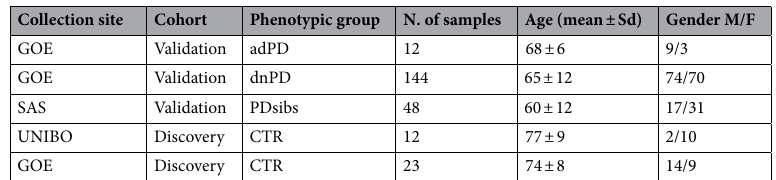
Table 3. Samples of the validation cohort. The validation was performed on 191 total samples: dnPD and adPD were analysed and compared with CTR from the discovery cohort.